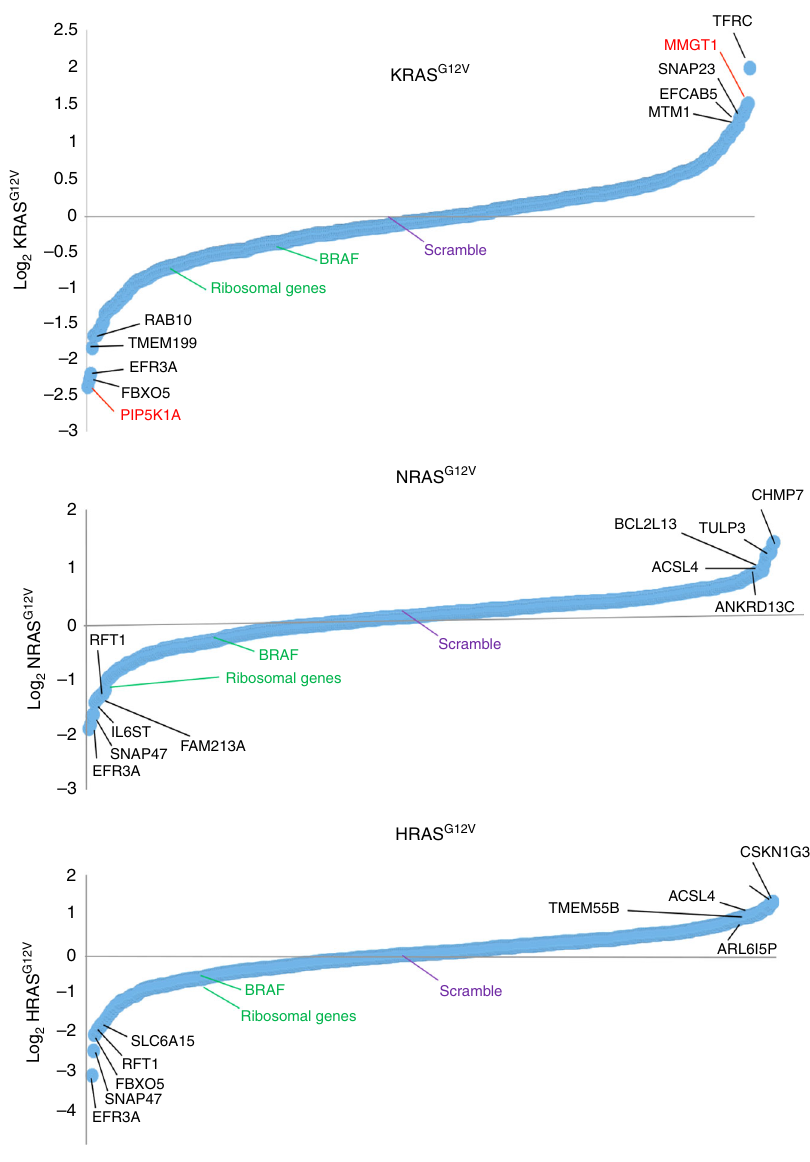
Fig. 2 Loss-of-function analysis identi fi es critical components of the RAS interactomes. Waterfall plot of the sgRNA log 2 enrichment score of each of the 474 genes encoding interactome proteins targeted by Cas9/CRISPR-mediated loss-of-function ( fi lled circle) in cells transformed by KRAS G12V (top), NRAS G12V (middle), or HRAS G12V (bottom). Enrichment scores for control ribosomal and BRAF genes, as well as scramble sgRNA, are shown for reference. Top 1% of positively and negatively enriched genes are labeled (black: enriched in cells transformed by multiple RAS isoforms; red: enriched in cells transformed by only one RAS